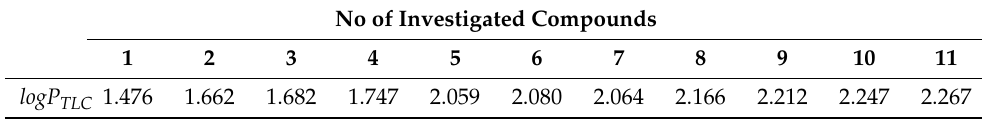
Table 4. The logP TLC values of investigated compounds 1 – 11 .